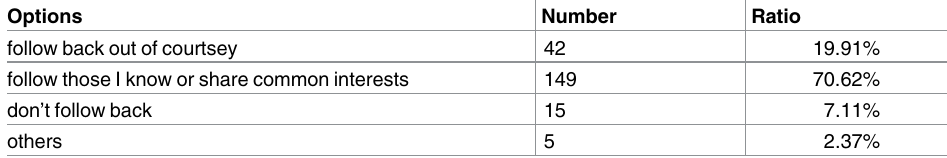
Table 2. If someone follows you, will you follow